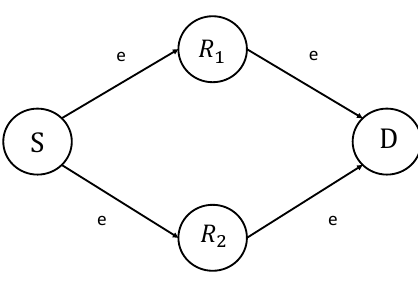
Figure 1. The topology of a two-relay network.